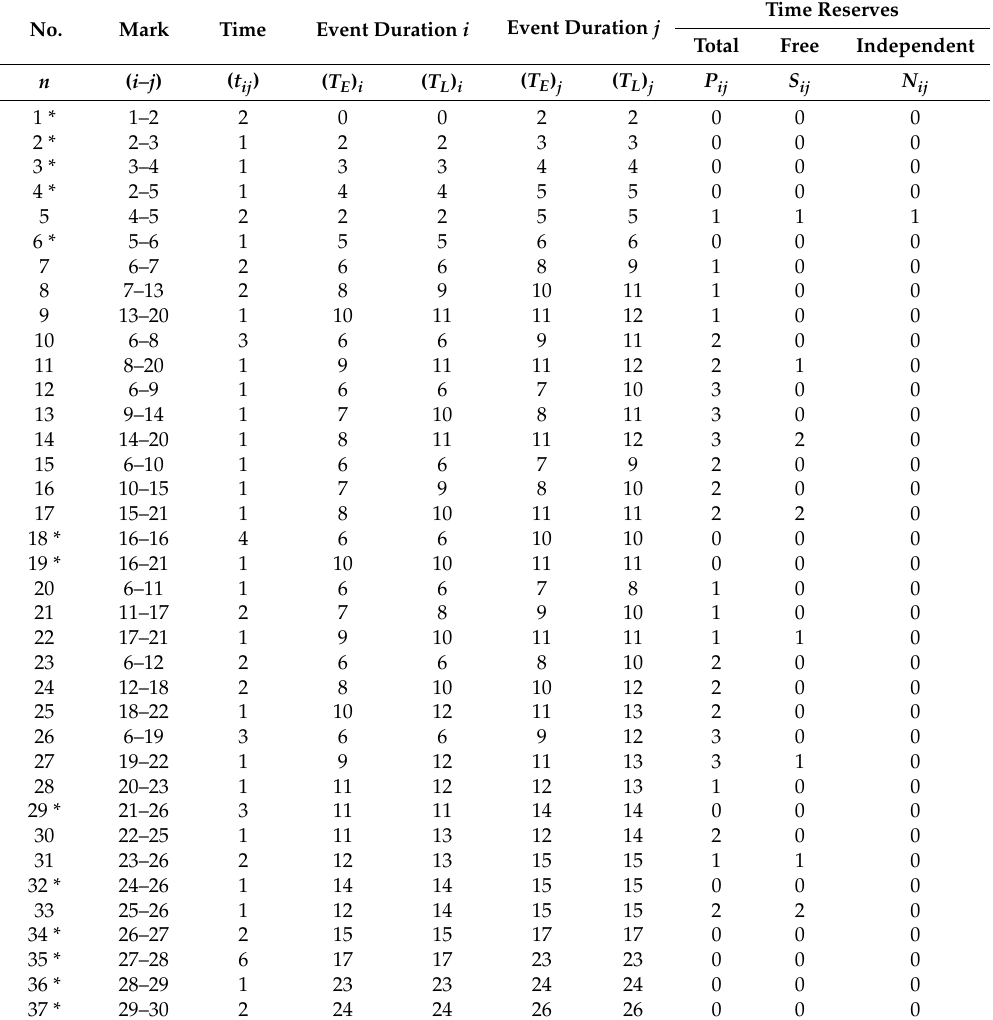
Table 6. Results of activity duration analysis within project